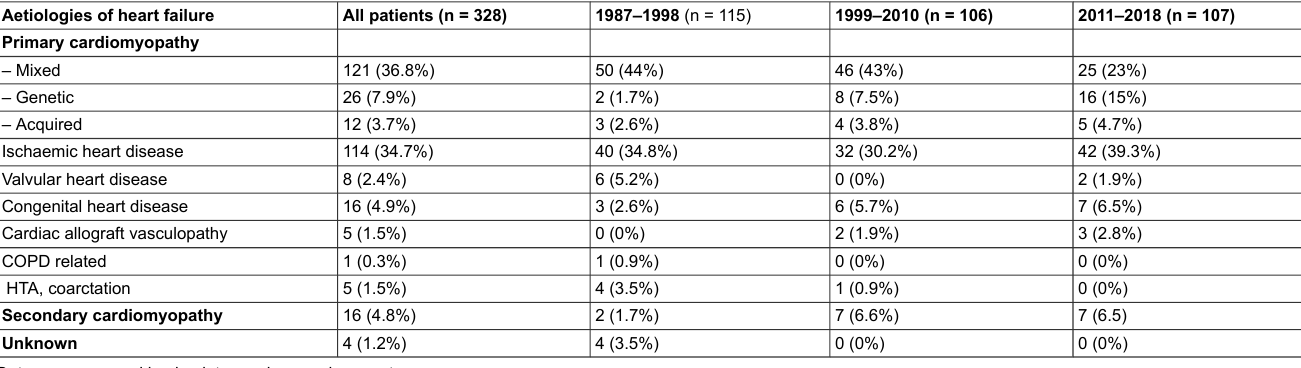
Table 2: Aetiologies of heart